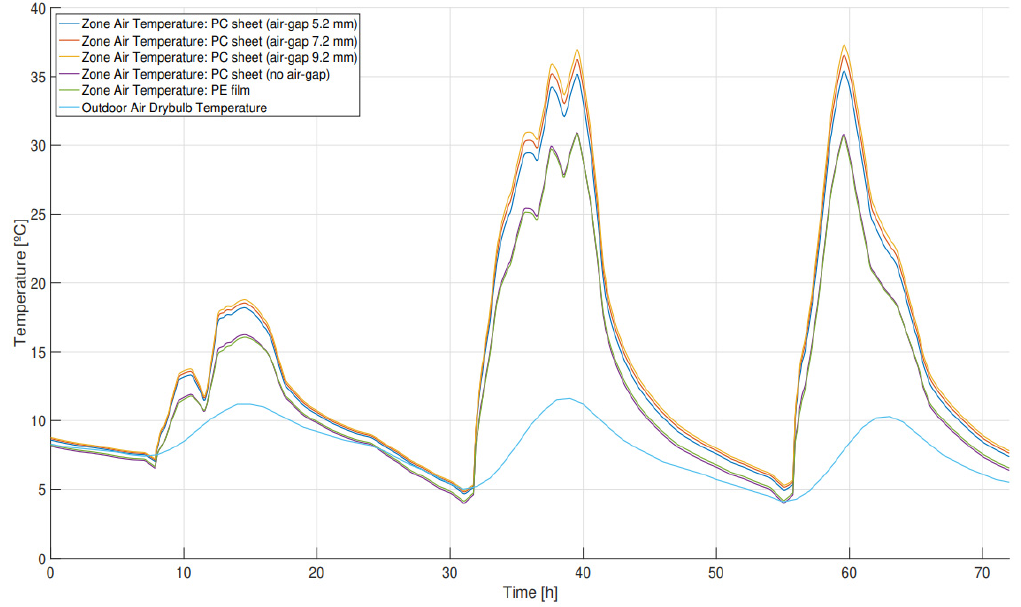
Figure 3. The unconditioned temperature inside and outside the greenhouse between the 29 and 31 of January for the different glazing materials.